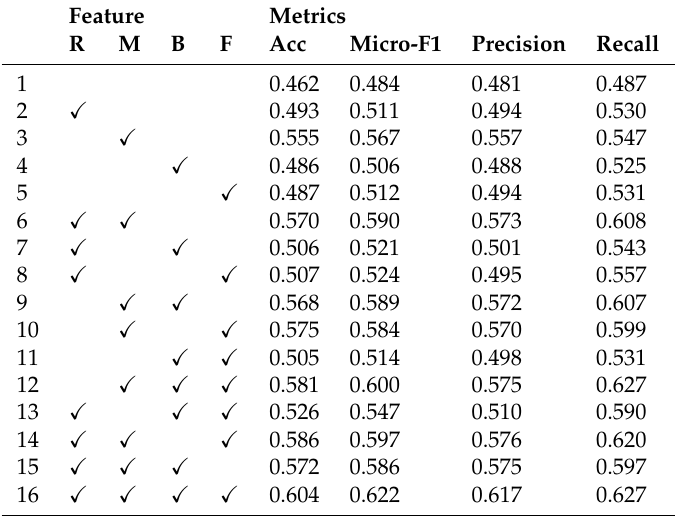
Table 1. Performance evaluation under different feature conditions (showing performance on the XGBOOST